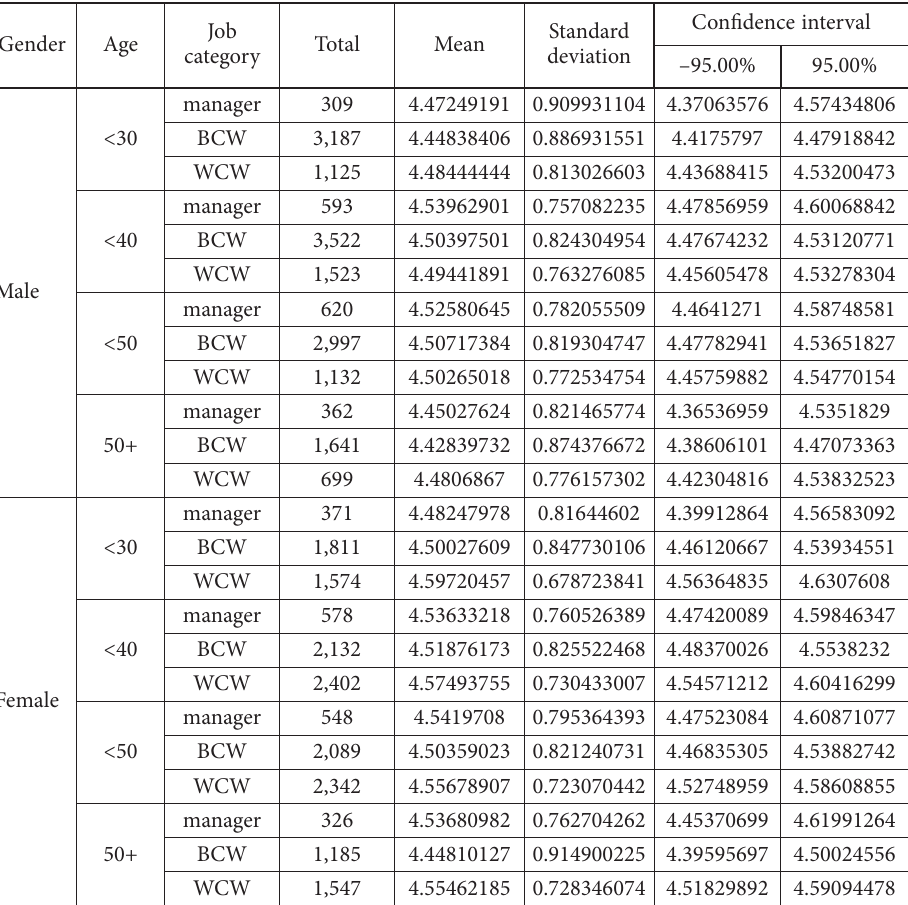
Table 3. Descriptive statistics of the motivation factor basic